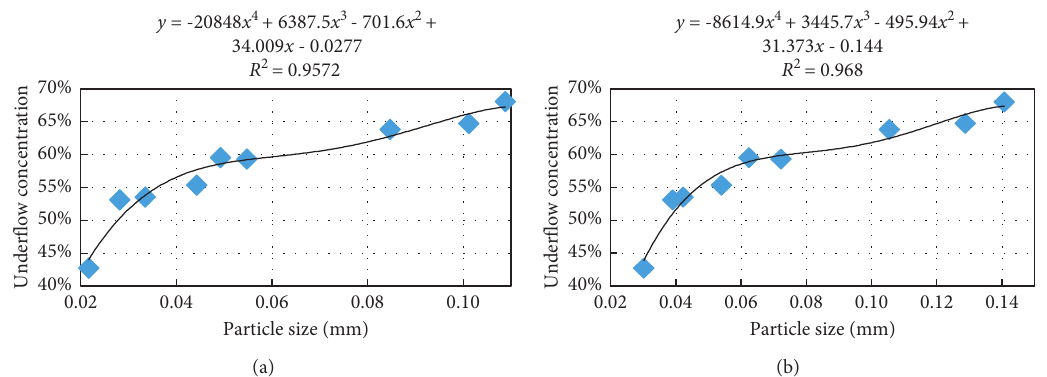
Figure 3: Nonlinear relation between particle size of tailings and underflow concentration. (a) Median particle size of tailings. (b) Control particle size of tailings.